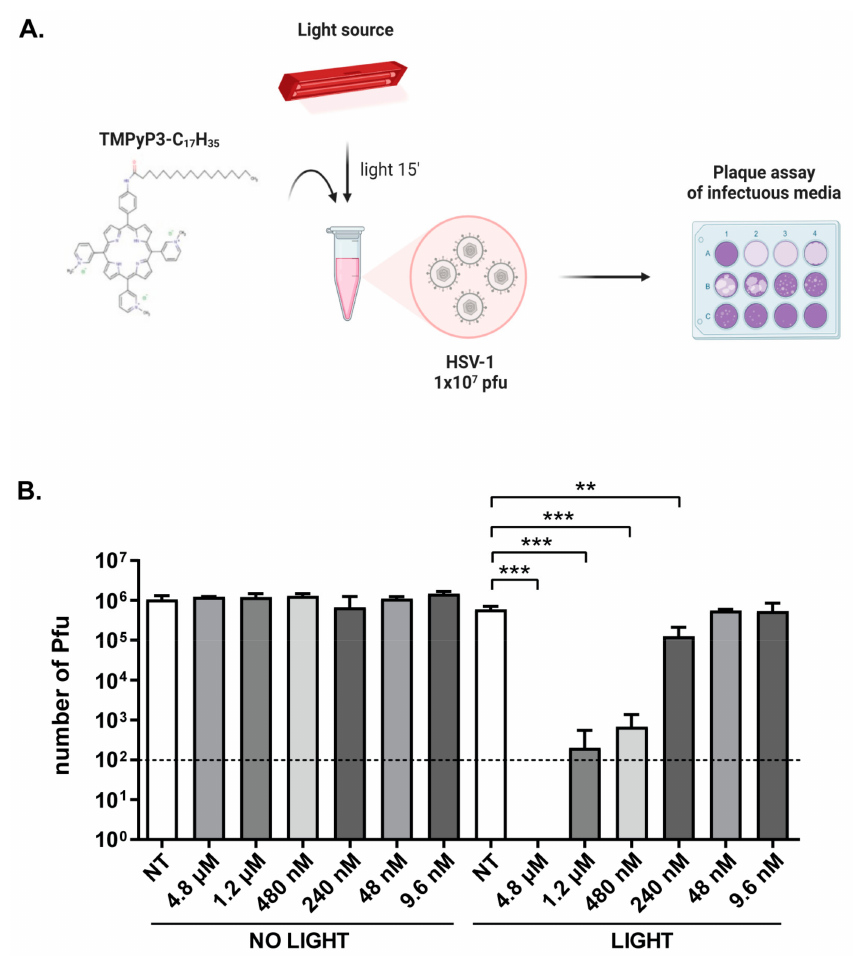
Figure 8. Direct effect of TMPyP3-C 17 H 35 on HSV-1 virions. A suspension of HSV-1 (~1 × 10 6 virions) was treated with TMPyP3-C 17 H 35 at final concentrations of 4.8 µ M, 1.2 µ M, 480 nM, 240 nM, 48 nM, or 9.6 nM, and exposed to a light source. ( A ) Schematic representation of the experiment. ( B ) The number of plaque-forming units in sample was determined by plaque assay. All samples were tested in triplicate, and data were analyzed using unpaired t-test ( p values indicate significant differences; *** p = 0.0008, ** p = 0.0046). The dashed line in the graph represents the detection limit of the experiment (100